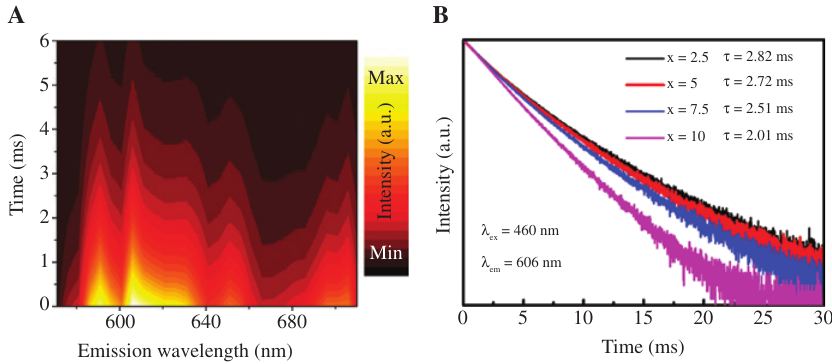
:Eu 3 + nanocrystals. 2 :10%Eu 3 + . (B) Emission decay curves of the 5 D 2